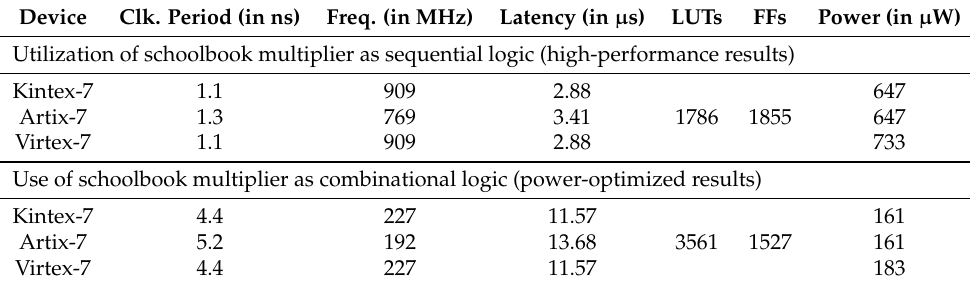
Table 1. Implementation results of the proposed ECP accelerator architecture on modern FPGA devices.